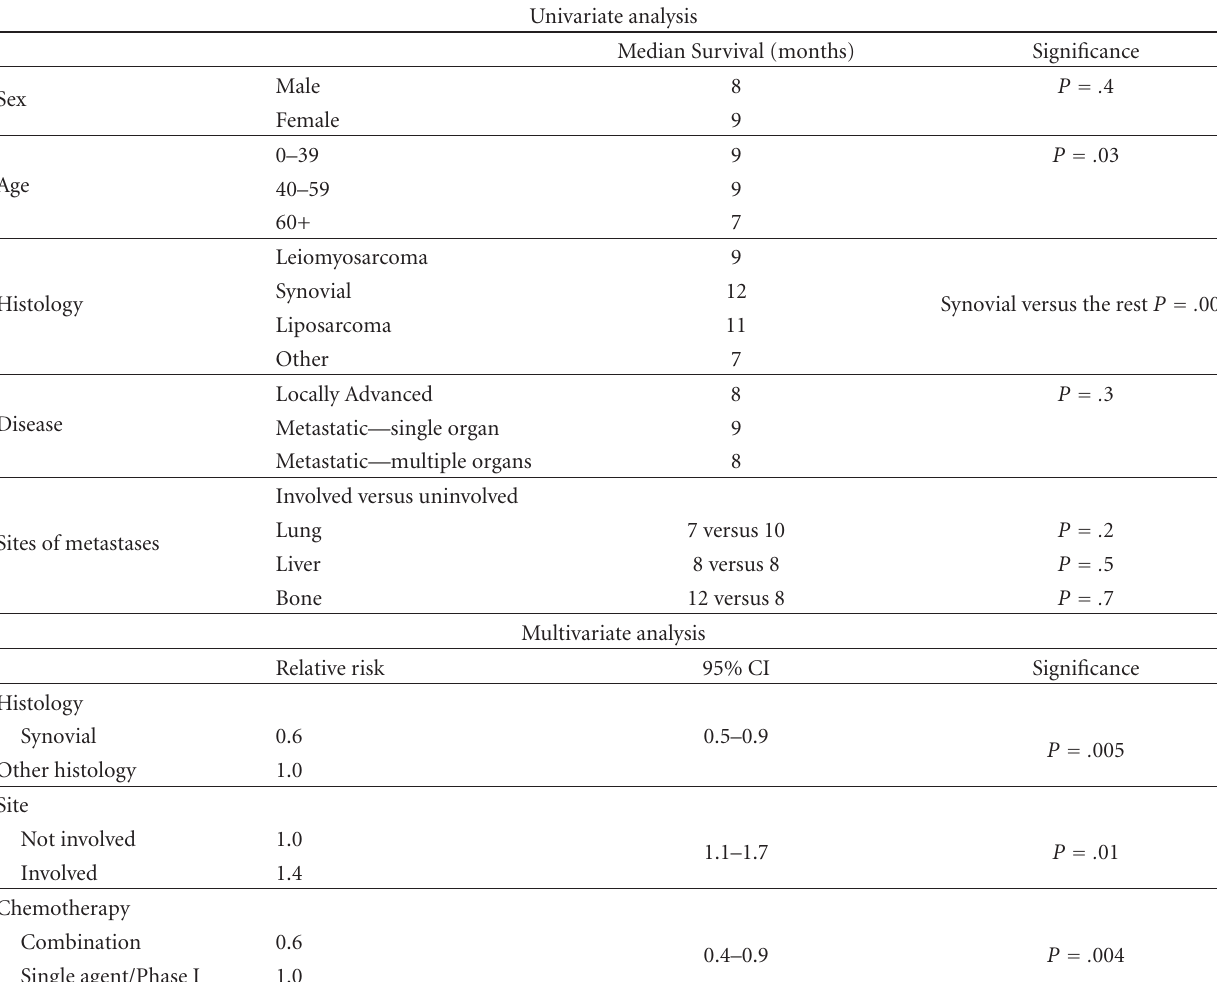
Table 6: Univariate analysis (Life table & Logrank) and multivariate analysis (Cox regression) of survival. Univariate